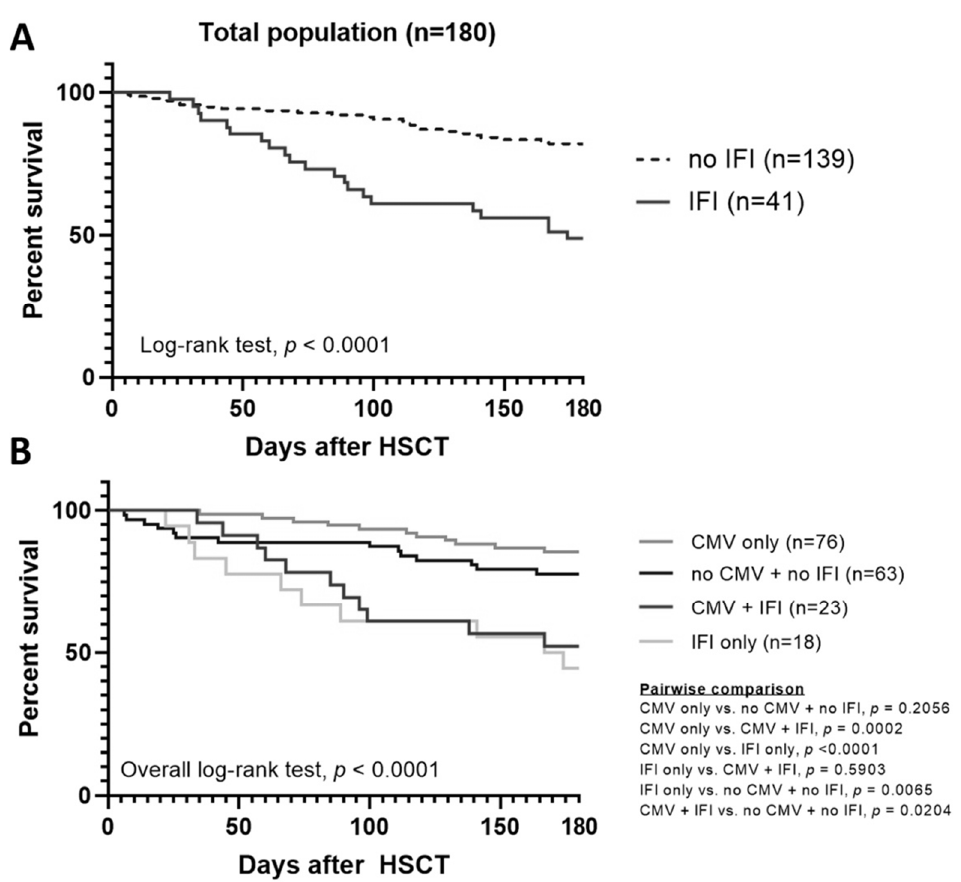
Figure 2. Kaplan–Meier 180-day survival estimates after HSCT. ( A ) IFI vs no IFI, and ( B ) four subgroups according to CMV reactivation and IFI.